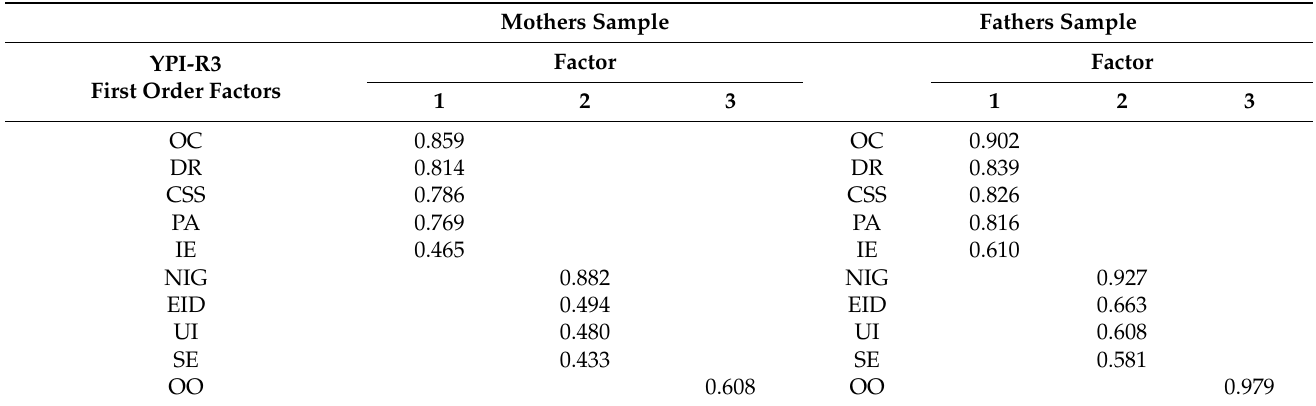
Table 3. Three-Factor Solution for YPI-R3 using the Singapore Mothers and Fathers